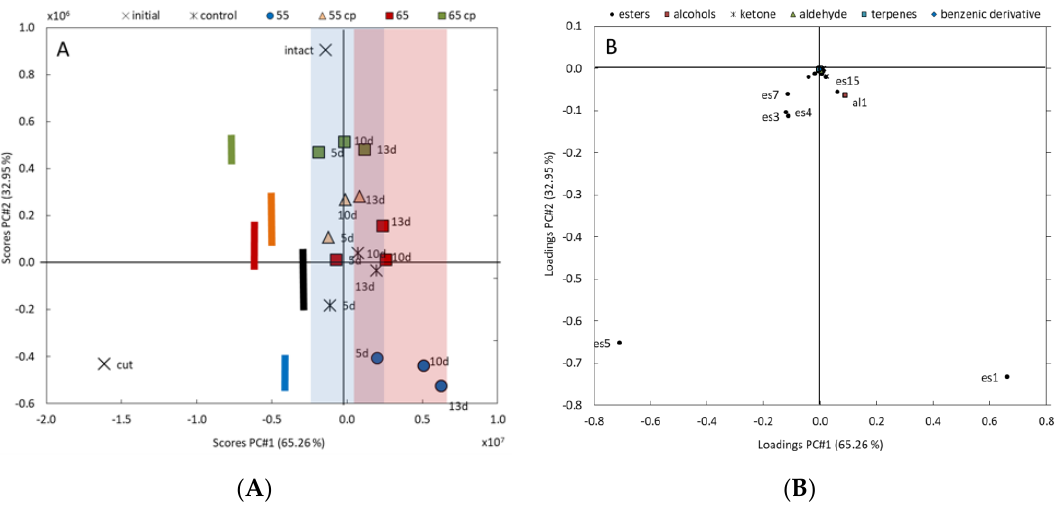
Figure 2. ( A ) Scatterplot of principal components analysis (PCA)-results of the variability of VOCs profiles during storage of treated and untreated fresh-cut apple slices. Decreasing scores of PC1 and PC2 can be associated with the effects of cutting; scores values of PC1 are associated with storage time, marked by colored areas (blue = 3 d and red = 10 d); decreasing scores of PC2 additional associated with distinct effects of the various treatments, marked by colored bars. ( B ) Loading plot of PCA-results of single-VOC impact on the total variance in VOCs profiles. VOCs with negative loadings of both PCs can be associated with the effects of cutting; VOCs with positive PC1 and negative PC2 loadings are related during storage and distinct effects of the treatments.